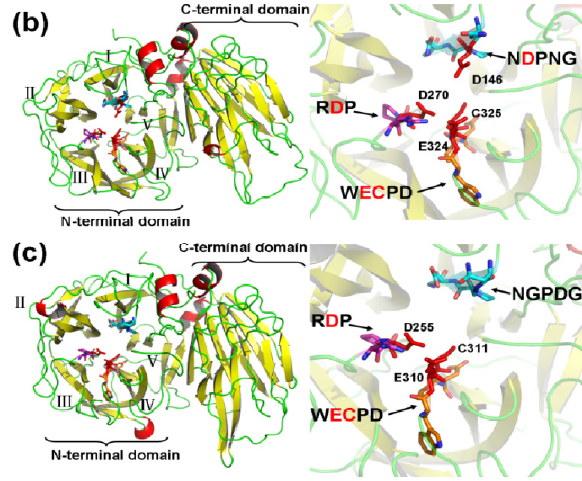
Figure 6. The cartoon representation and active site of the predicted 3D structure model of MeVINVs. Roman numerals (I–V) show the five blades of the β -propeller module, respectively. The graphics at the right side show a close-up view of the active site. The motifs (NDPNG or NGPDG, RDP, and WECPD) are shown as sticks, and the red sticks indicate the catalytic residues. Single-letter amino acid abbreviations are used with position